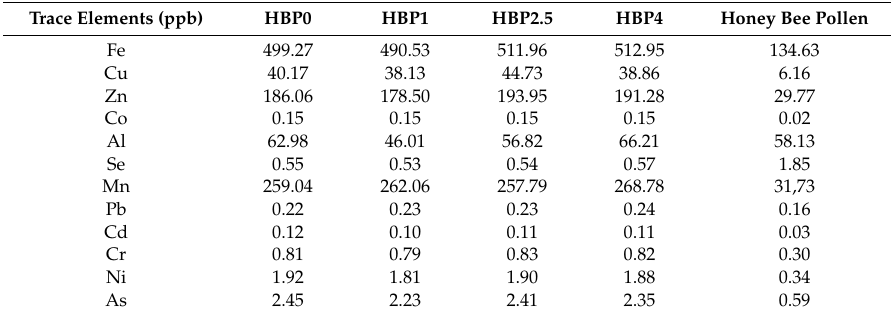
Table 3. Toxic and essential trace elements in experimental feeds and honey bee pollen.